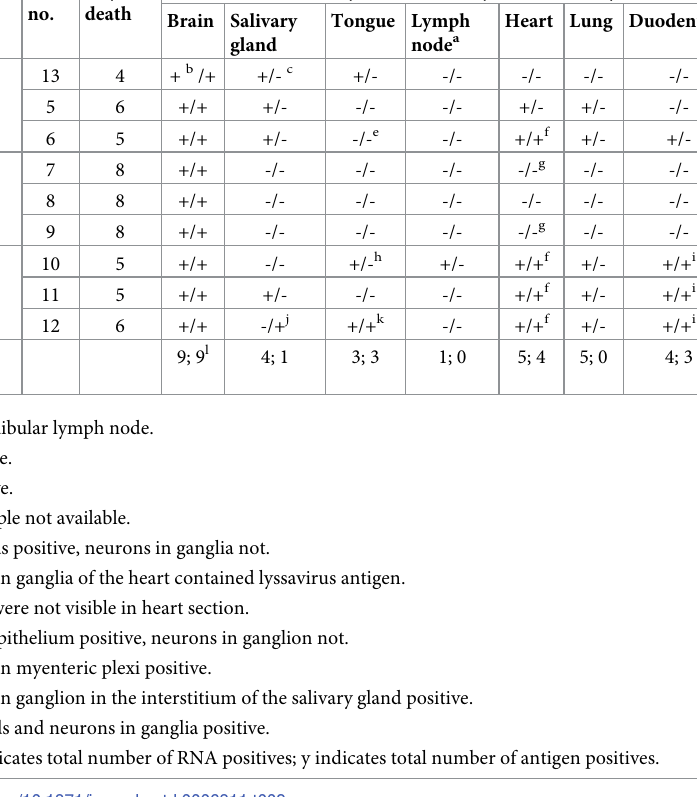
Table 2. Distribution of Lagos bat viral RNA and antigen in tissues of experimentally infected bats. Inoculum Bat Group